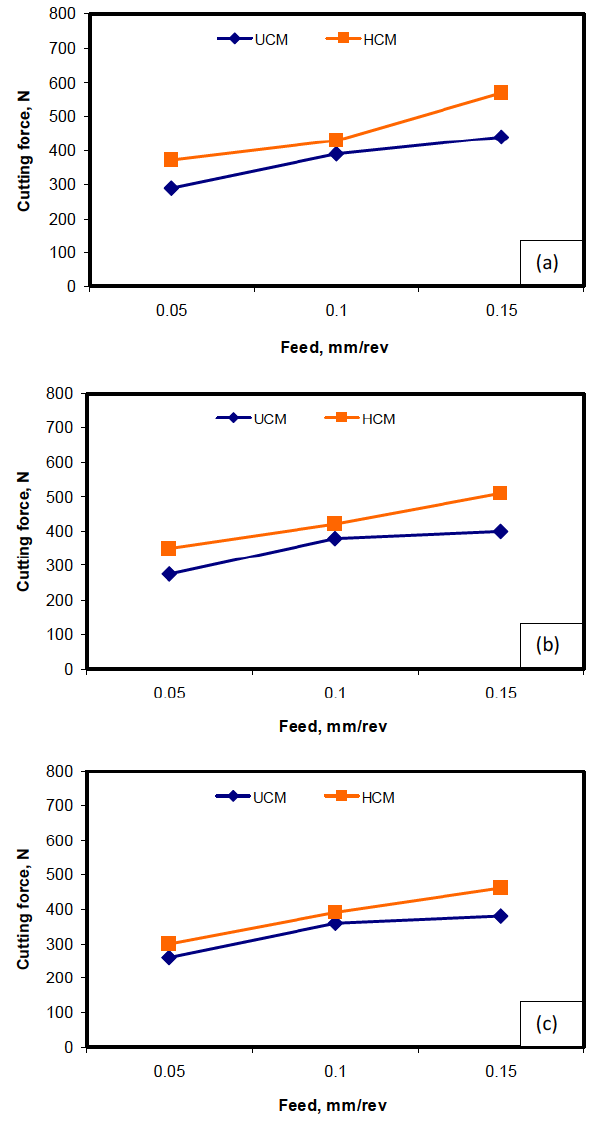
Figure 4: Variation of cutting force with increasing feed rate (a) cutting speed 95 m/min, depth of cut 0.25 mm (b) cutting speed 125 m/min, depth of cut 0.25 mm (c) cutting speed 175 m/min, depth of cut 0.25